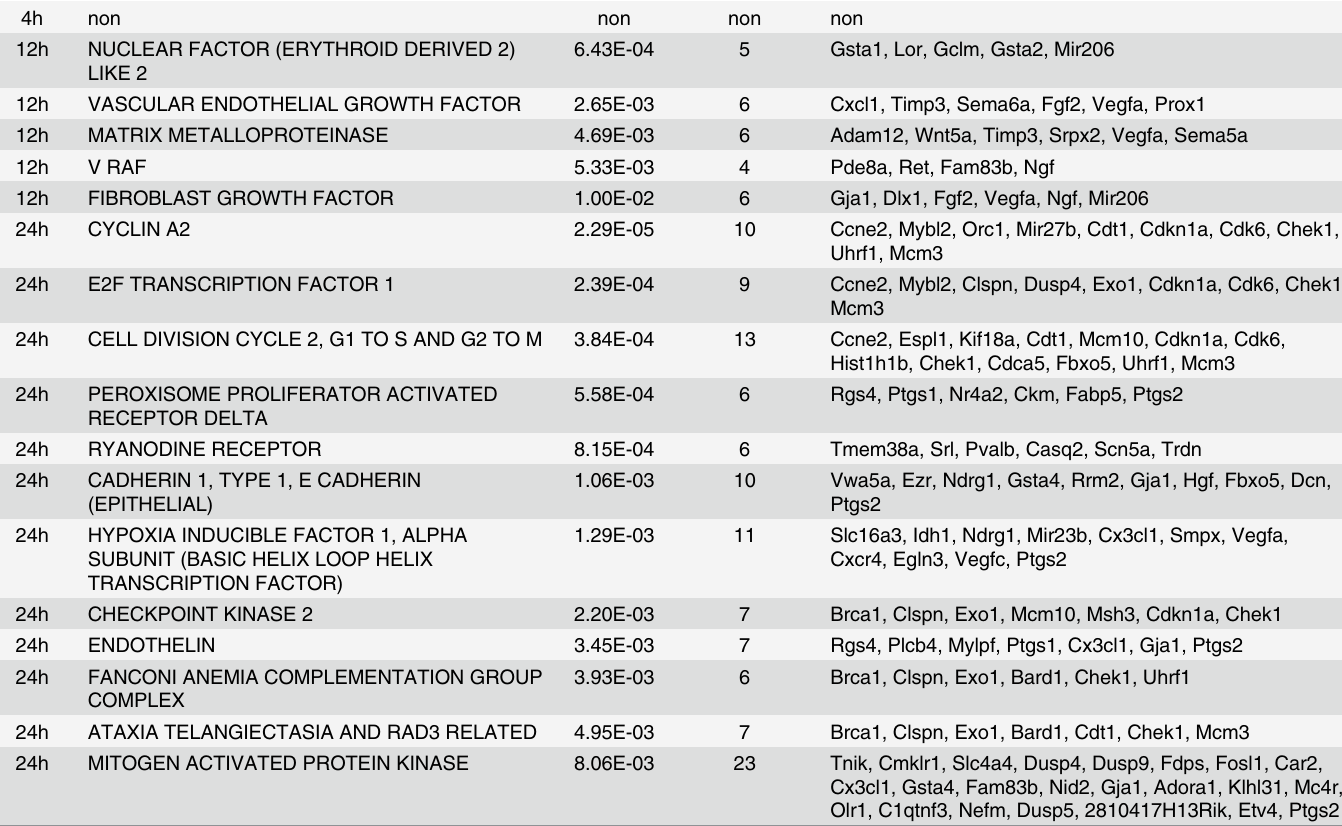
(4-h differentiation), mothers against DPP homolog (Smad) and TGFbeta pathway associa- tions were significantly enriched amongst others (Table 3). During very early differentiation (12-h differentiation), signaling pathways such as mothers against DPP homolog, notch, and semaphorin were enriched (Table 3). After 24-h differentiation (early differentiation) enrich- ment analysis of pathway associations revealed involvement of cyclin A2, ryanodine receptor, and E2F transcription factor 1 pathway among others (Table 3). For example, pathways related to TGFbeta or SMAD signaling (Table 3) were additionally allocated to SOTA cluster C. How- ever, part of the enriched signal transduction pathway association included genes which were not similarly regulated during myoblast differentiation as the respective pathway associations were not retrieved in SOTA clusters. In contrast to the effect of myoblast differentiation, the effect of TNF- α treatment on gene expression, and thus pathway enrichment, was approximately constant over time (Table 3). However, slight time-specific enrichment of signal transduction pathway associations were evi- dent as the number of signal transduction pathway associations peaks at 12 h after induction